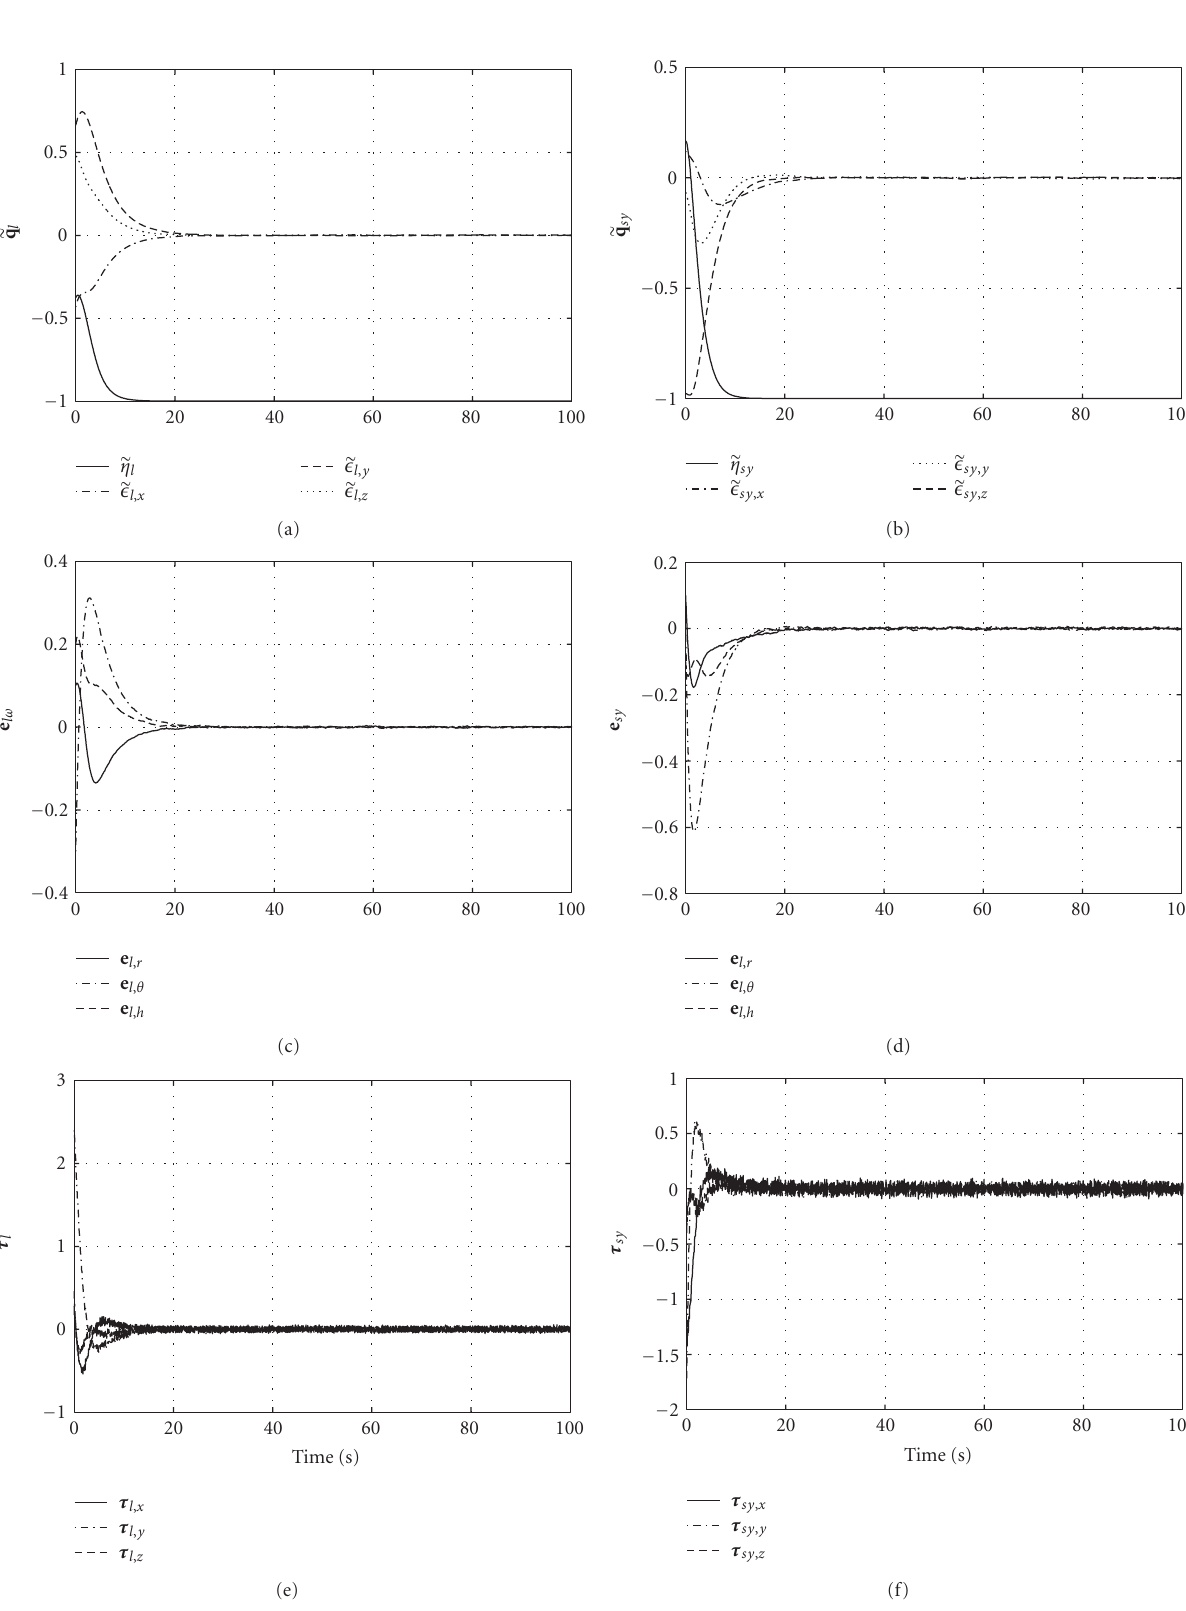
Figure 3: Attitude and angular velocity error and control torque for leader ((a, (c), (e))) and synchronizing follower ((b, (d), (f))) spacecraft during maneuver including measurement noise and